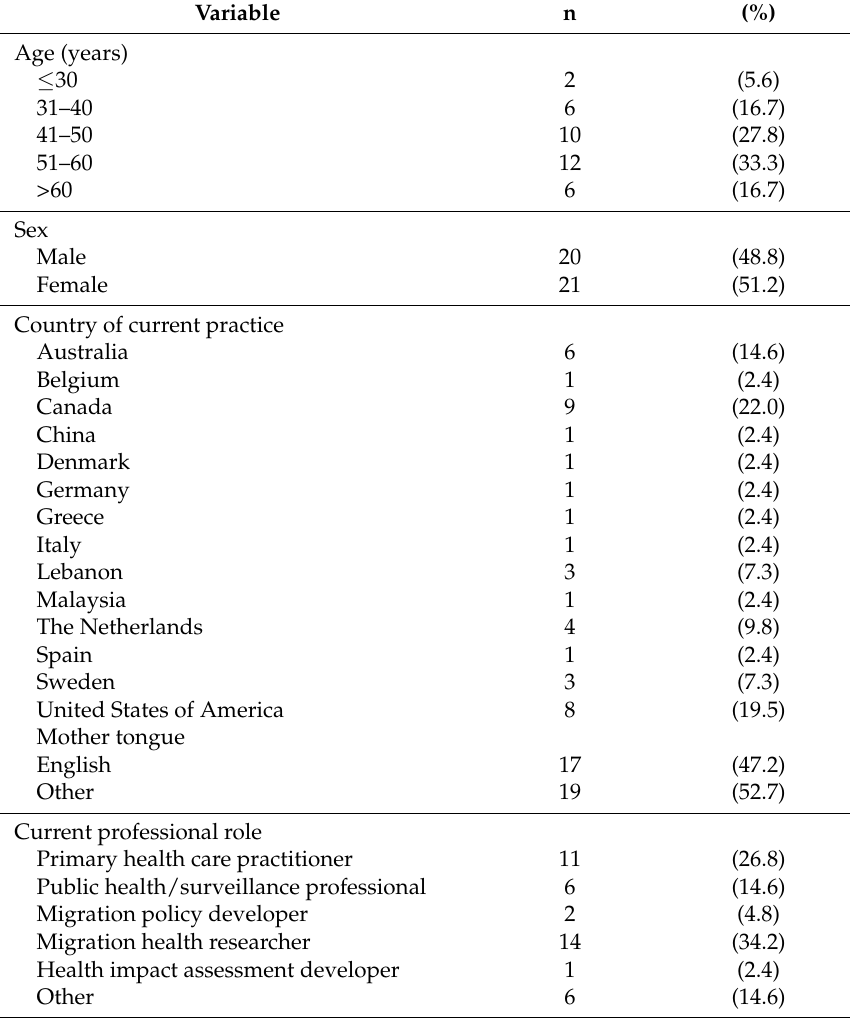
Figure 1. Delphi expert response rates over three phases. Table 1. Demographic and characteristics of panel experts.